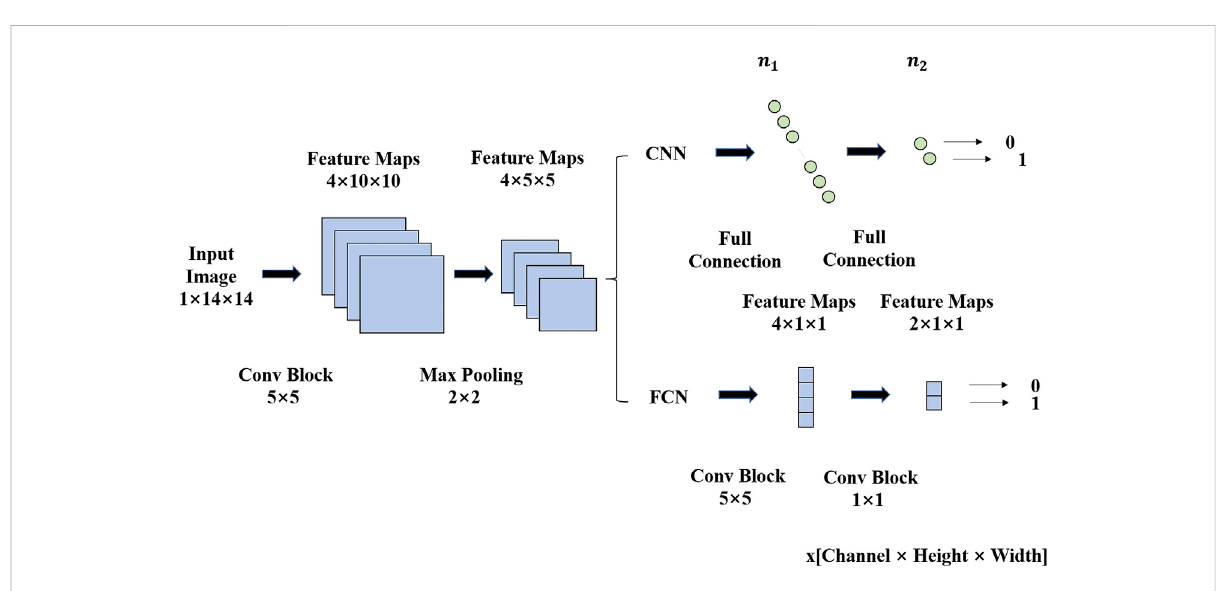
FIGURE 6 Comparison of CNN and